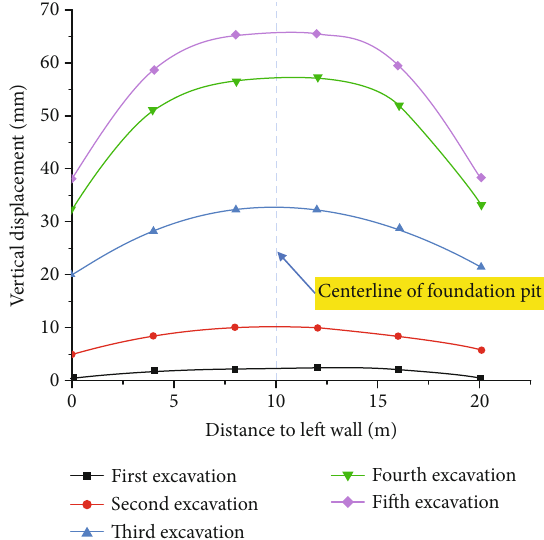
Figure 7: Uplift displacement of the bottom soil at each excavation stage.